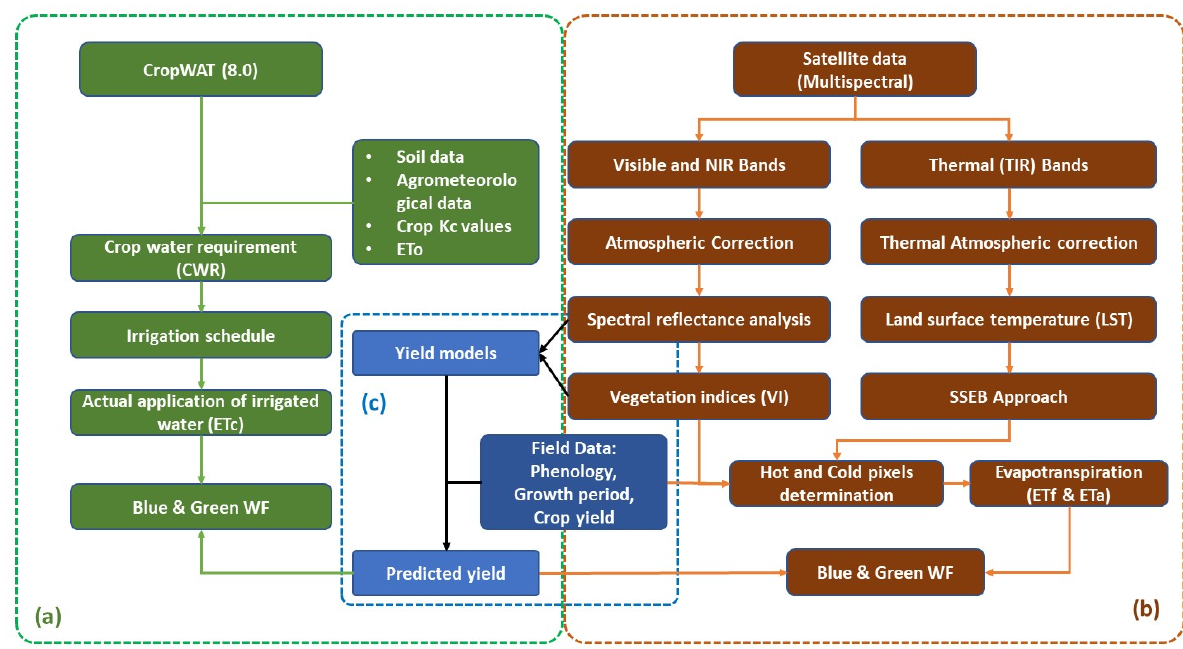
Figure 2. Methodological flow: ( a ) workflow of estimation of water footprint (WF) with the adoption of CROPWAT approach, indicated with green; ( b ) workflow of WF assessment using simplified surface energy balance (SSEB), coded with brown; and ( c ) crop yield prediction, indicated with